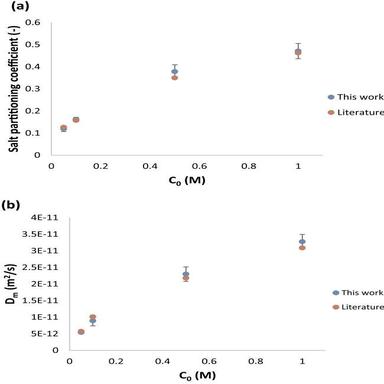
(a) Partitioning and (b) effective salt diffusion coefficients obtained in this work for Nafion 120 membrane compared with the literature.